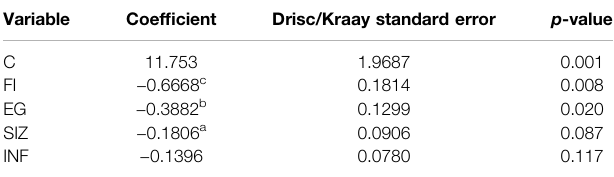
TABLE 7 | Driscoll – Kraay standard error regression